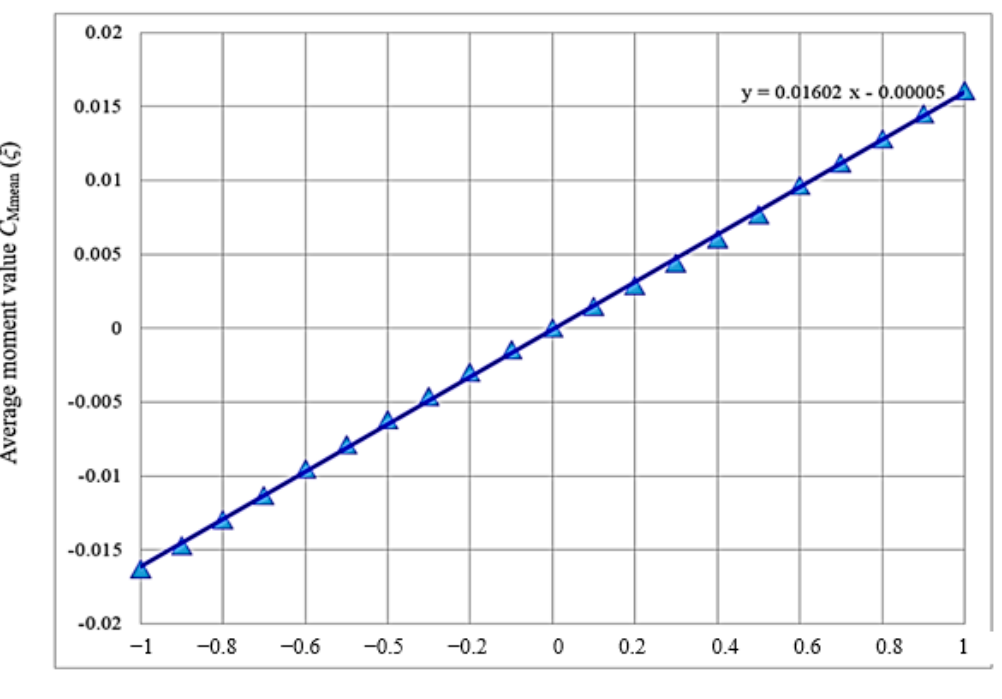
C M ( ξ , a ) di ff ers slightly because of the phase angle when the in fl ow velocity in the rotating